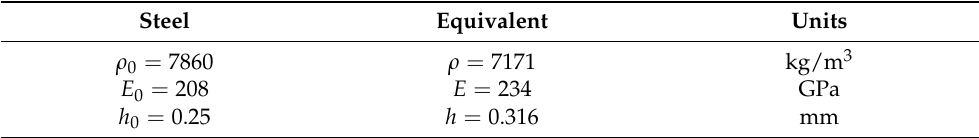
Table A1. Experimental and equivalent beam